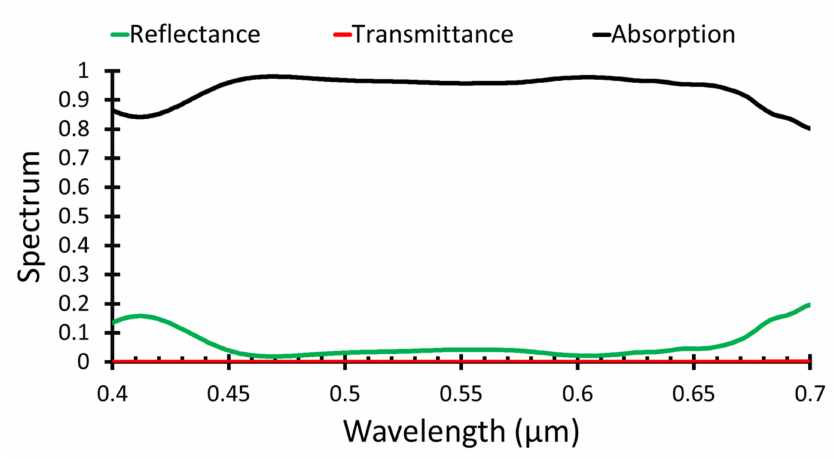
Figure 5. Absorbance, transmittance, and reflectance spectra of the proposed structure.